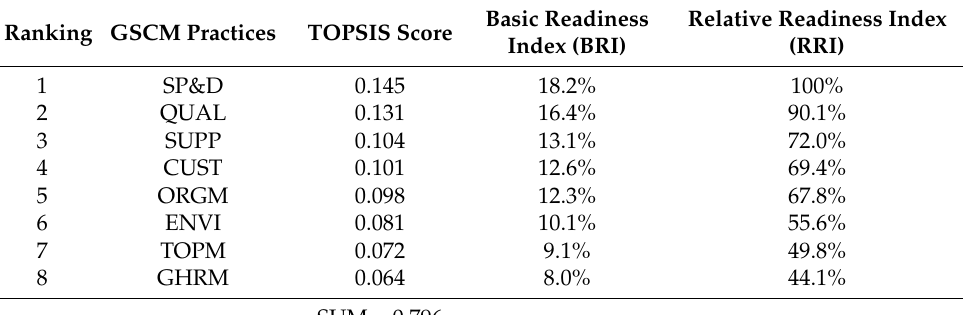
Proposed green supply chain management practice indices: basic readiness and relative